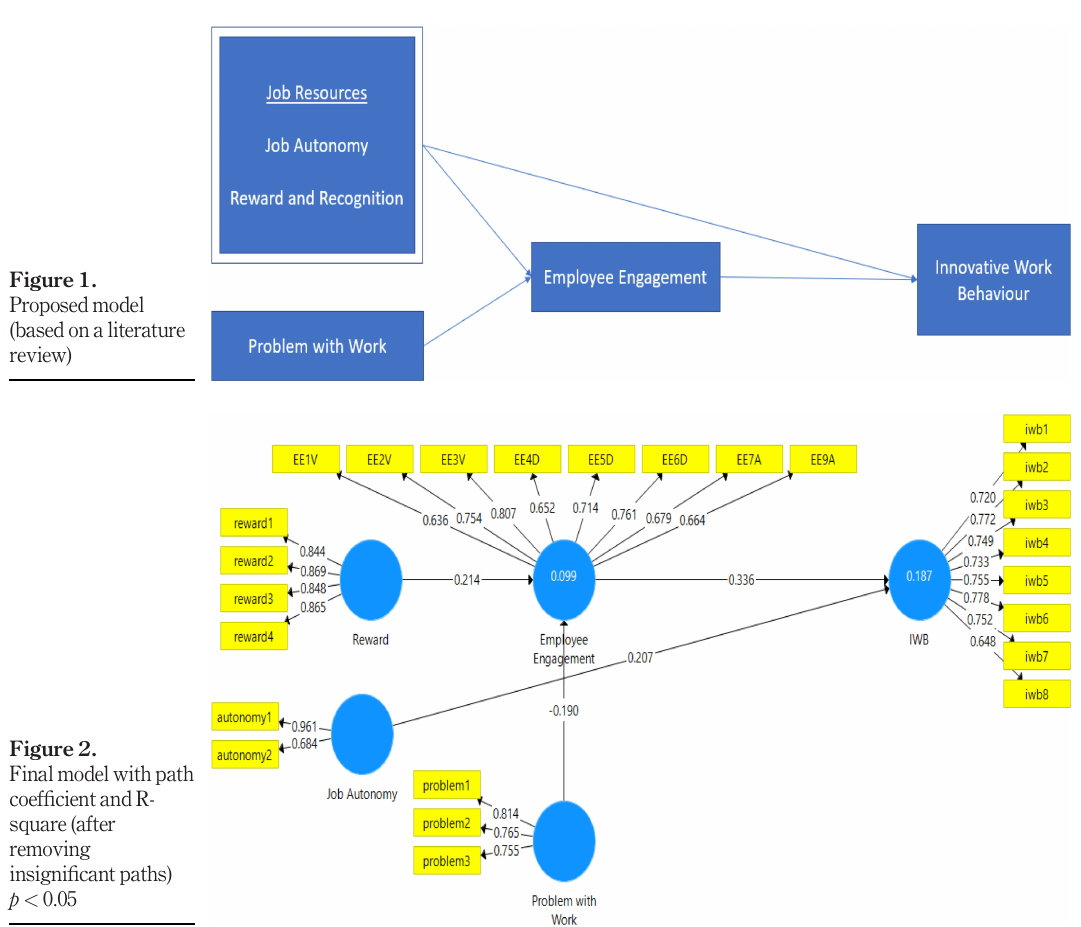
Figure 2. Final model with